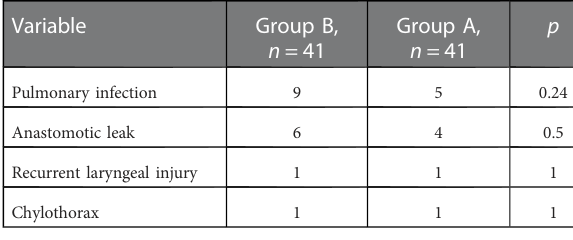
TABLE 3 Postoperative complications in two-ropes group Bnd regular group.